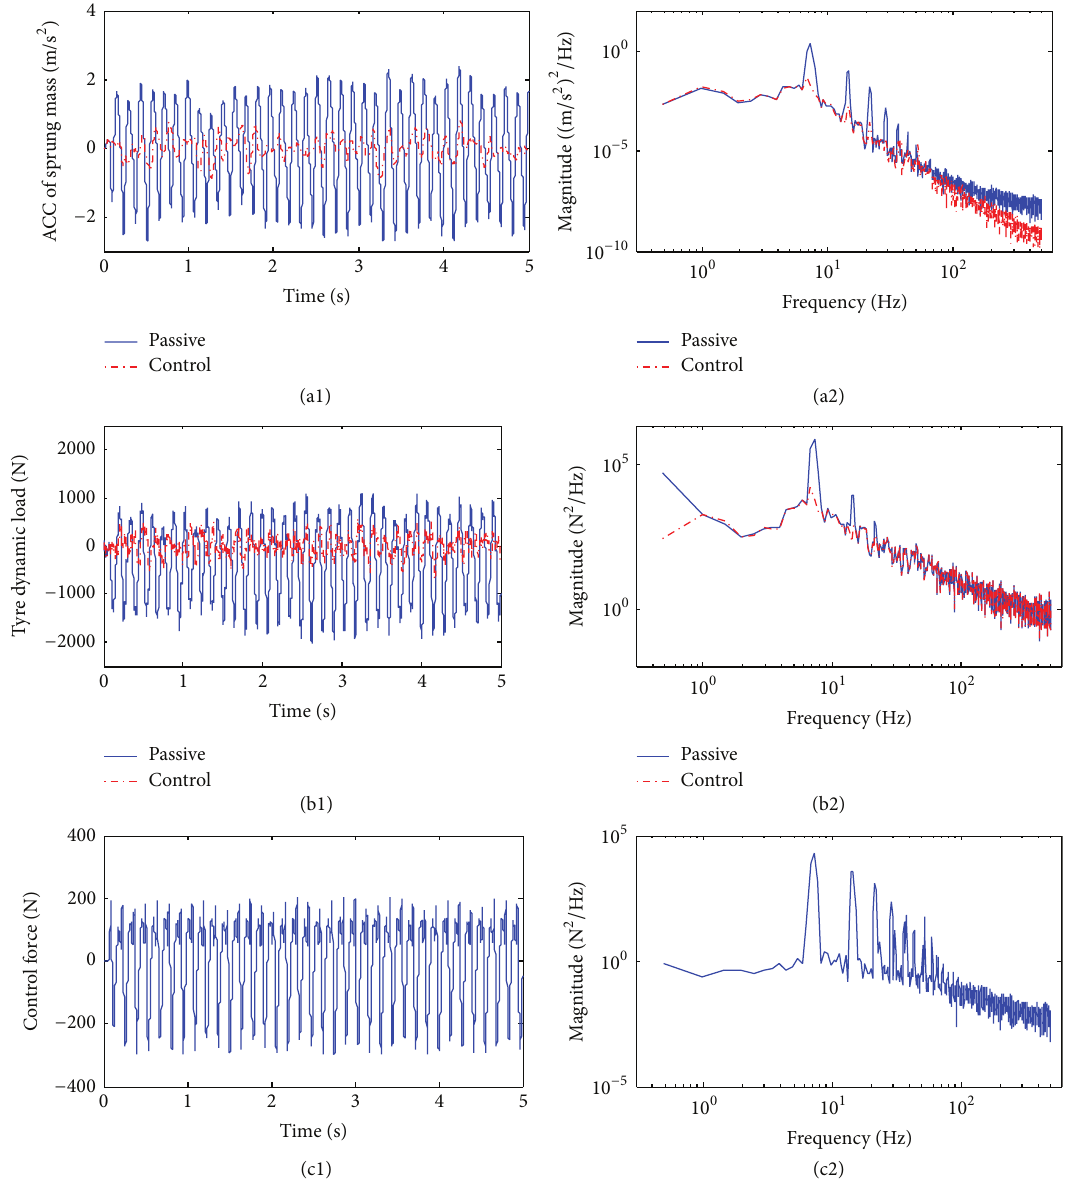
Figure 14: Suspension performance under FxLMS control at velocity 11km/h. (a1) Time history of sprung mass acceleration. (a2) PSD of sprung mass acceleration. (b1) Time history of tyre dynamic load. (b2) PSD of tyre dynamic load. (c1) Time history of suspension control force. (c2) PSD of suspension control